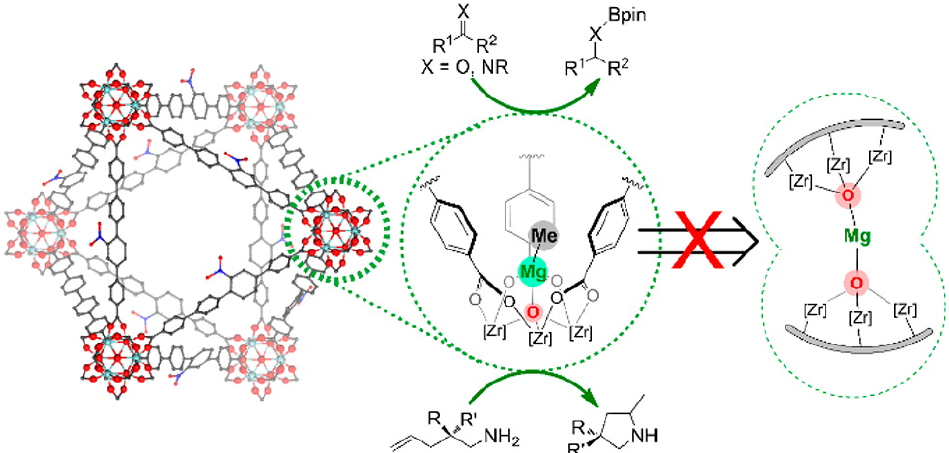
Figure 8. The site-isolation strategy of introducing MgMe sites as alkenes activation center. Red = O, Black = C, Blue = N, Green = Zr. Adapted with permission from [93]; Published by American Chemical Society, 2016.